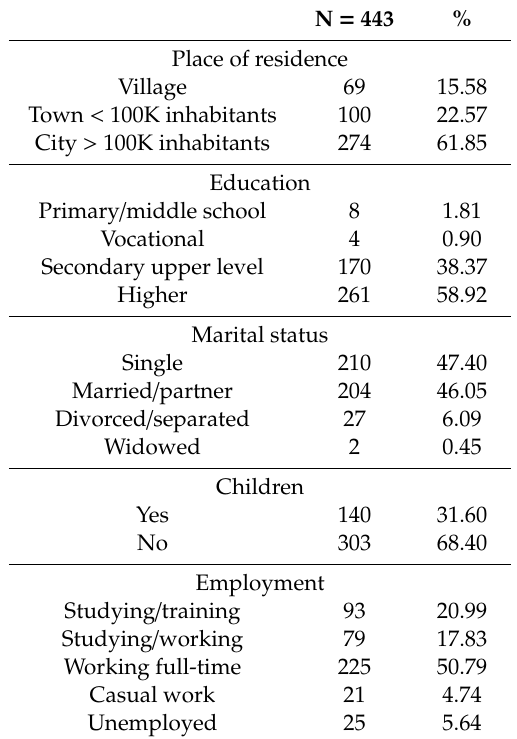
Table 1. Sociodemographic breakdown of Stage 1 subject group. N = 443